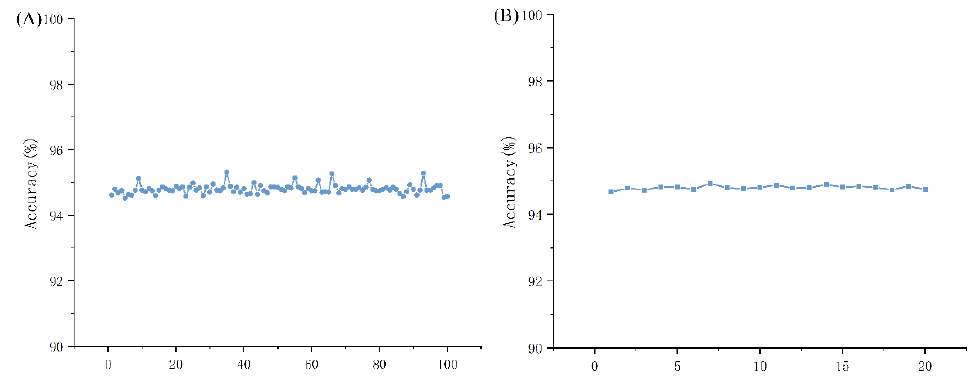
Figure 1 . ( A ) Graph showing the accuracy of 100 experiments; ( B ) graph showing the average accuracy of every 5th experiment out of 100 experiments. accuracy of every 5th experiment out of 100